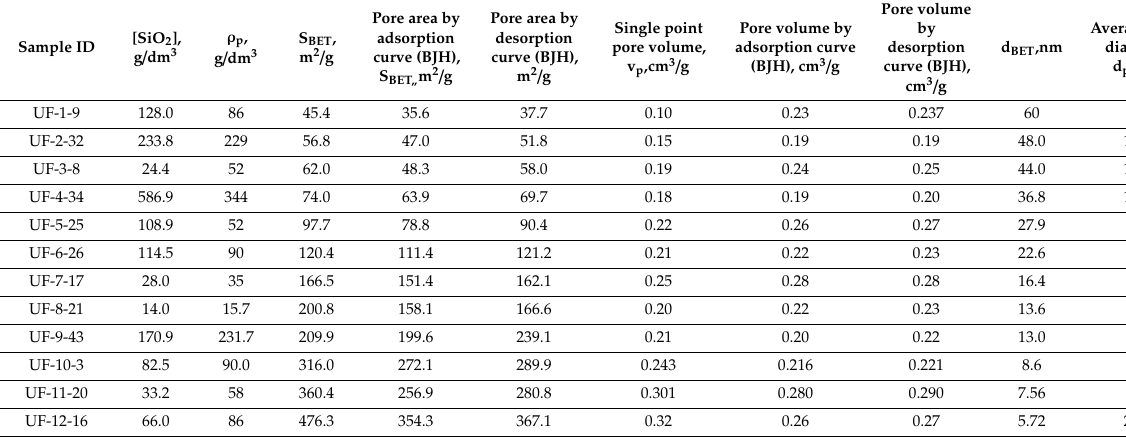
Table 3. Pore characteristics of powders established by low-temperature nitrogen adsorption.